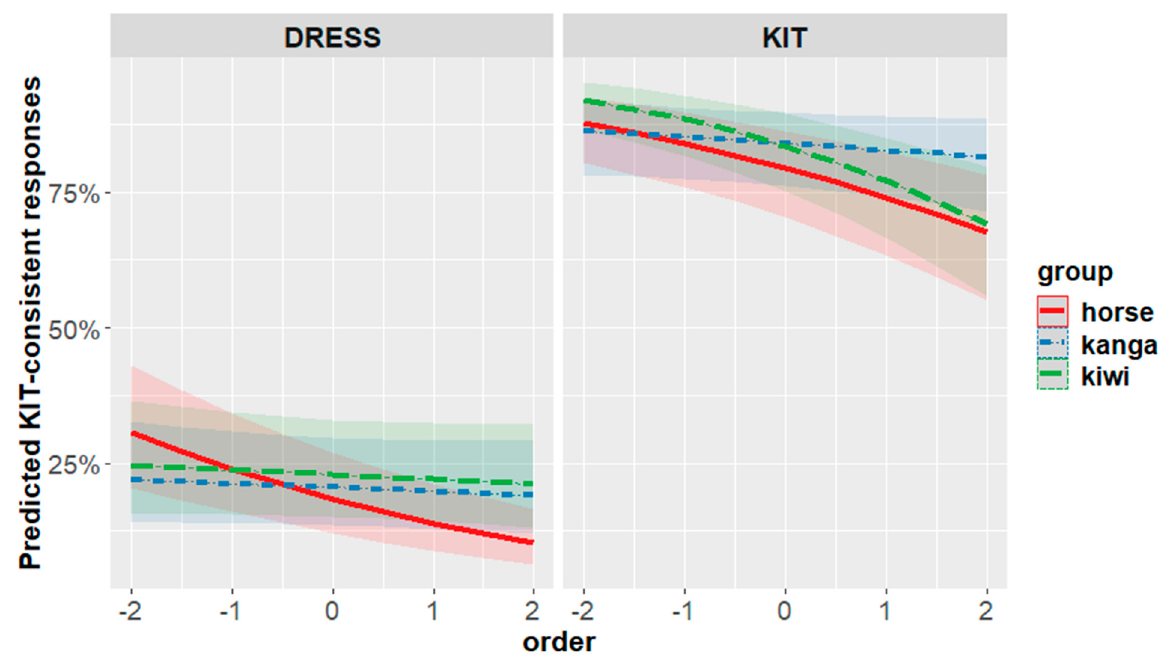
Figure 6. Model prediction plot from model of experiment two (see Table 7). Three-way interaction of order (x-axis), primetime (lines), and frame (panels), predicting percentage of KIT-consistent re-